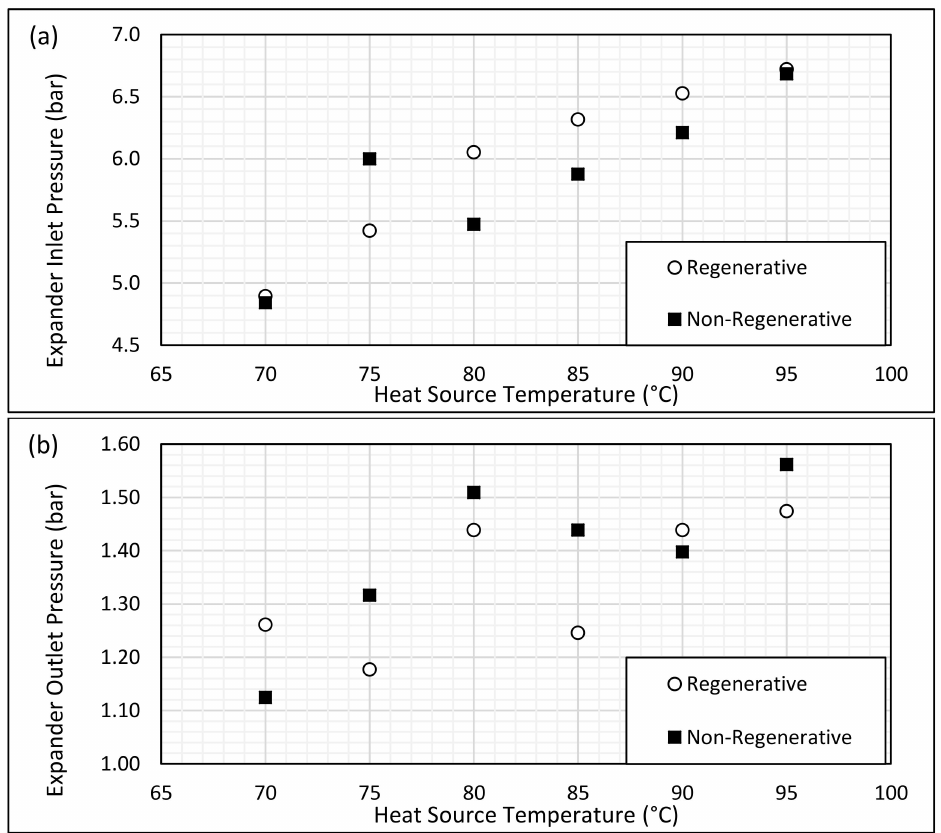
Figure 8. Variation in expander inlet (a) and outlet (b) pressure with changing heat source temperature.